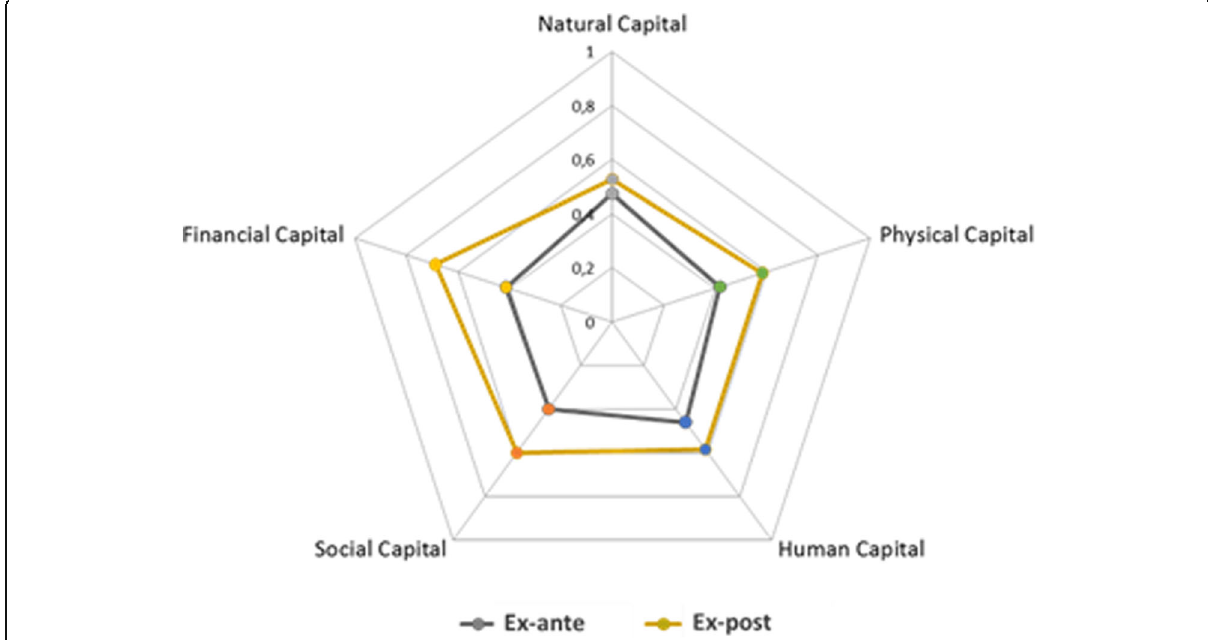
Fig. 11 Example of graphical output from the IEF